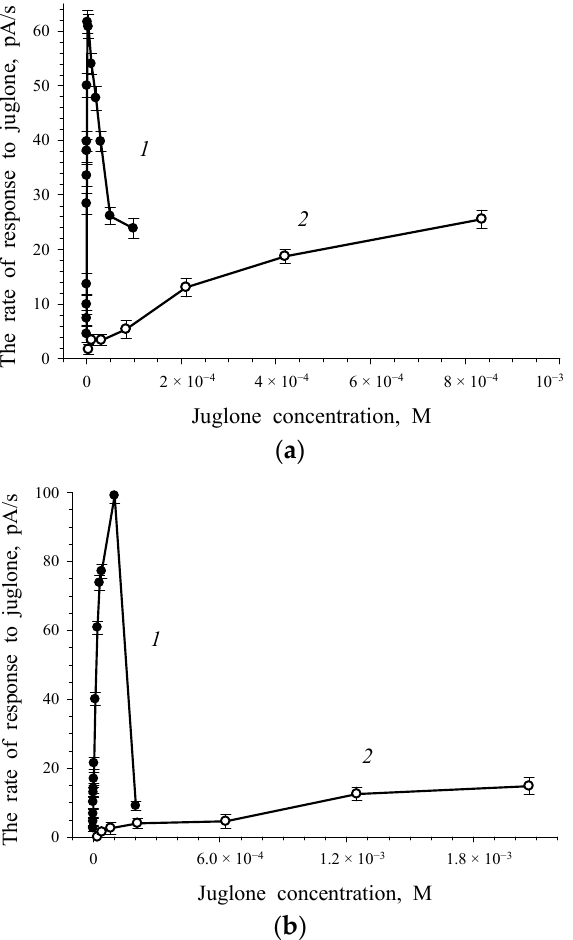
Figure 3. Dependences of the rate of the response to juglone on juglone concentration for intact ( a ) and immobilized ( b ) cells of Rhodococcus sp. 3 when the quinone form (curve 1 ) or phenolate form (curve 2 ) of juglone were used.